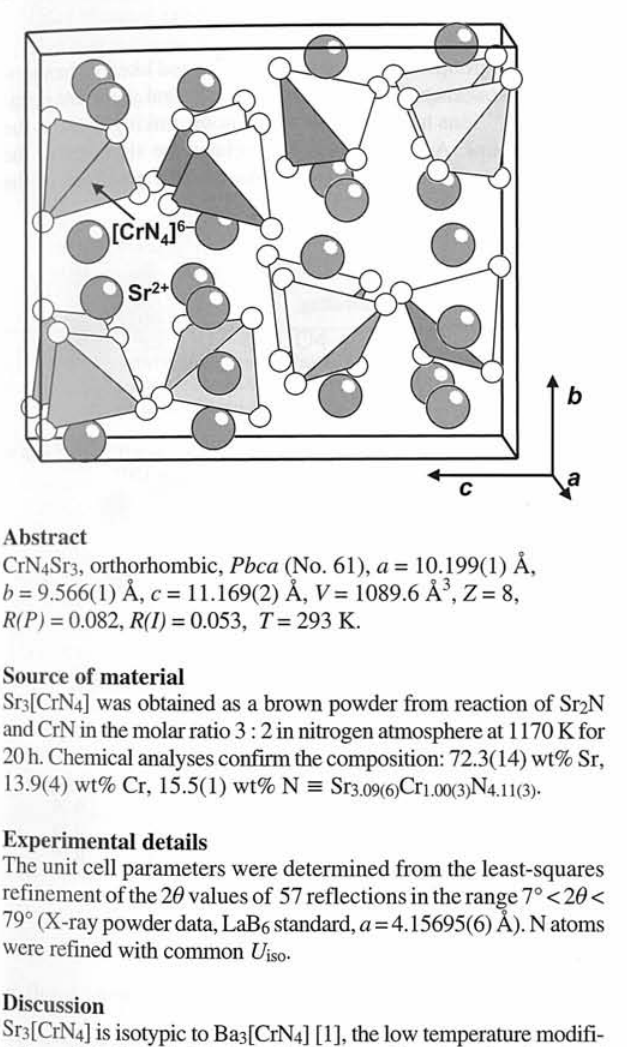
Table 1. Data collection and handling.